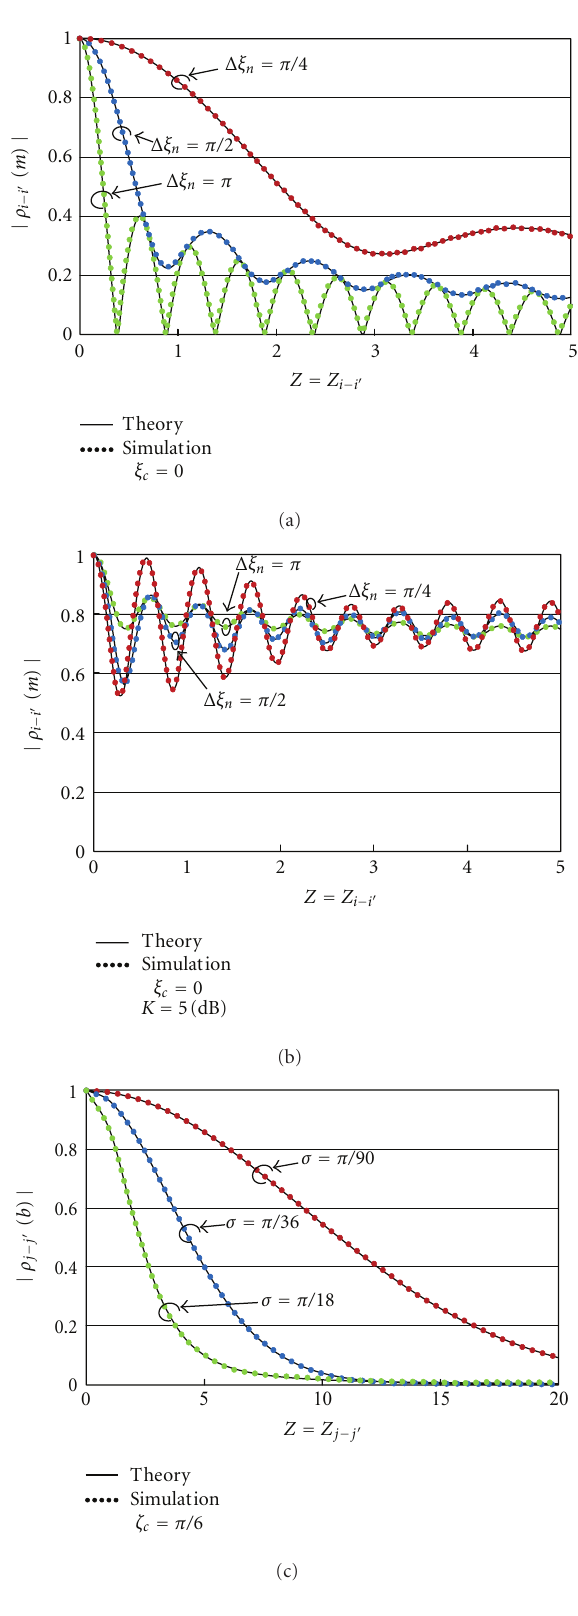
Figure 3: Correlation of one-side channel. (a) NLOS indoors (uniform distribution). (b) LOS indoors (uniform distribution). (c) NLOS outdoors (Gaussian